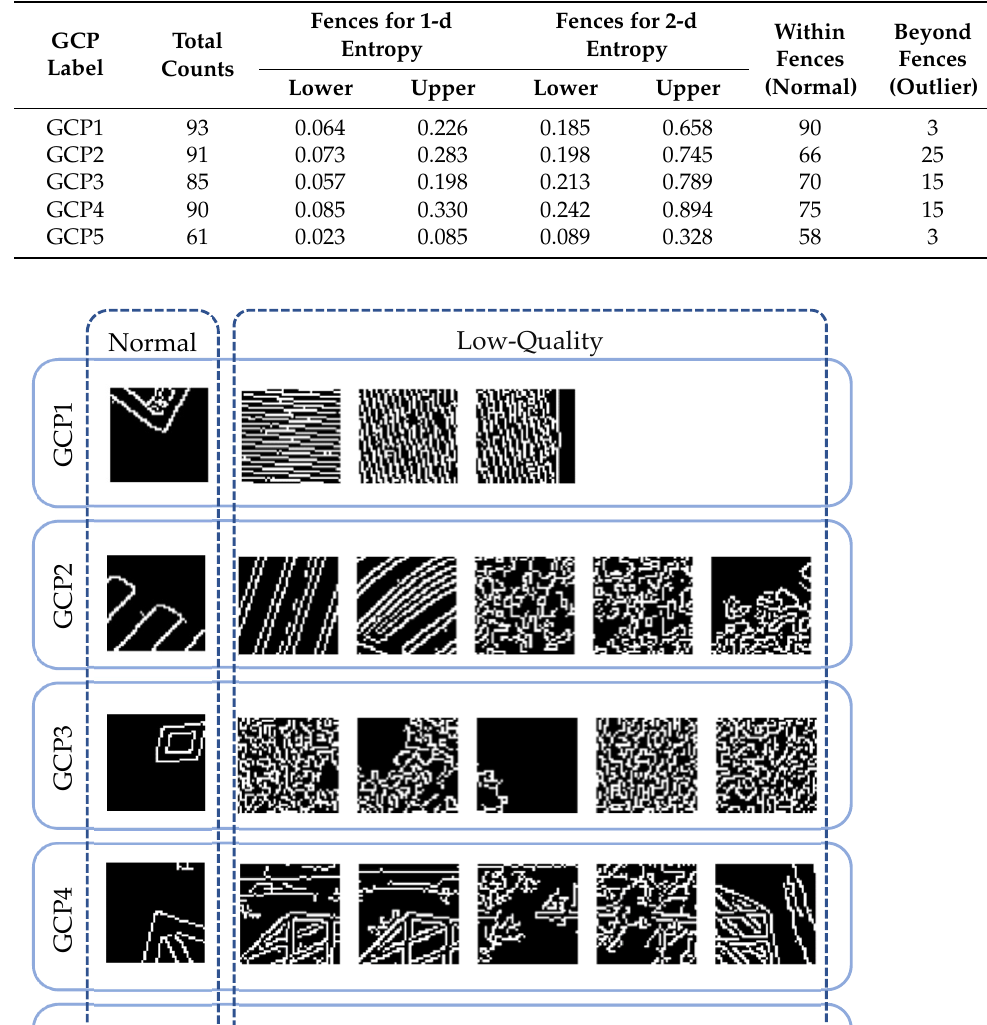
where TP, FP, TN and FN denote the counts of true positives, false positives, true negatives, and false negatives, respectively. The results are shown in Table 4. As Table 4 shows, the average sensitivity is 96.84%, and the average specificity is 98.2%, both of which are at high levels. Therefore, the adjusted boxplot is valid for low-quality ROI recognition and has high